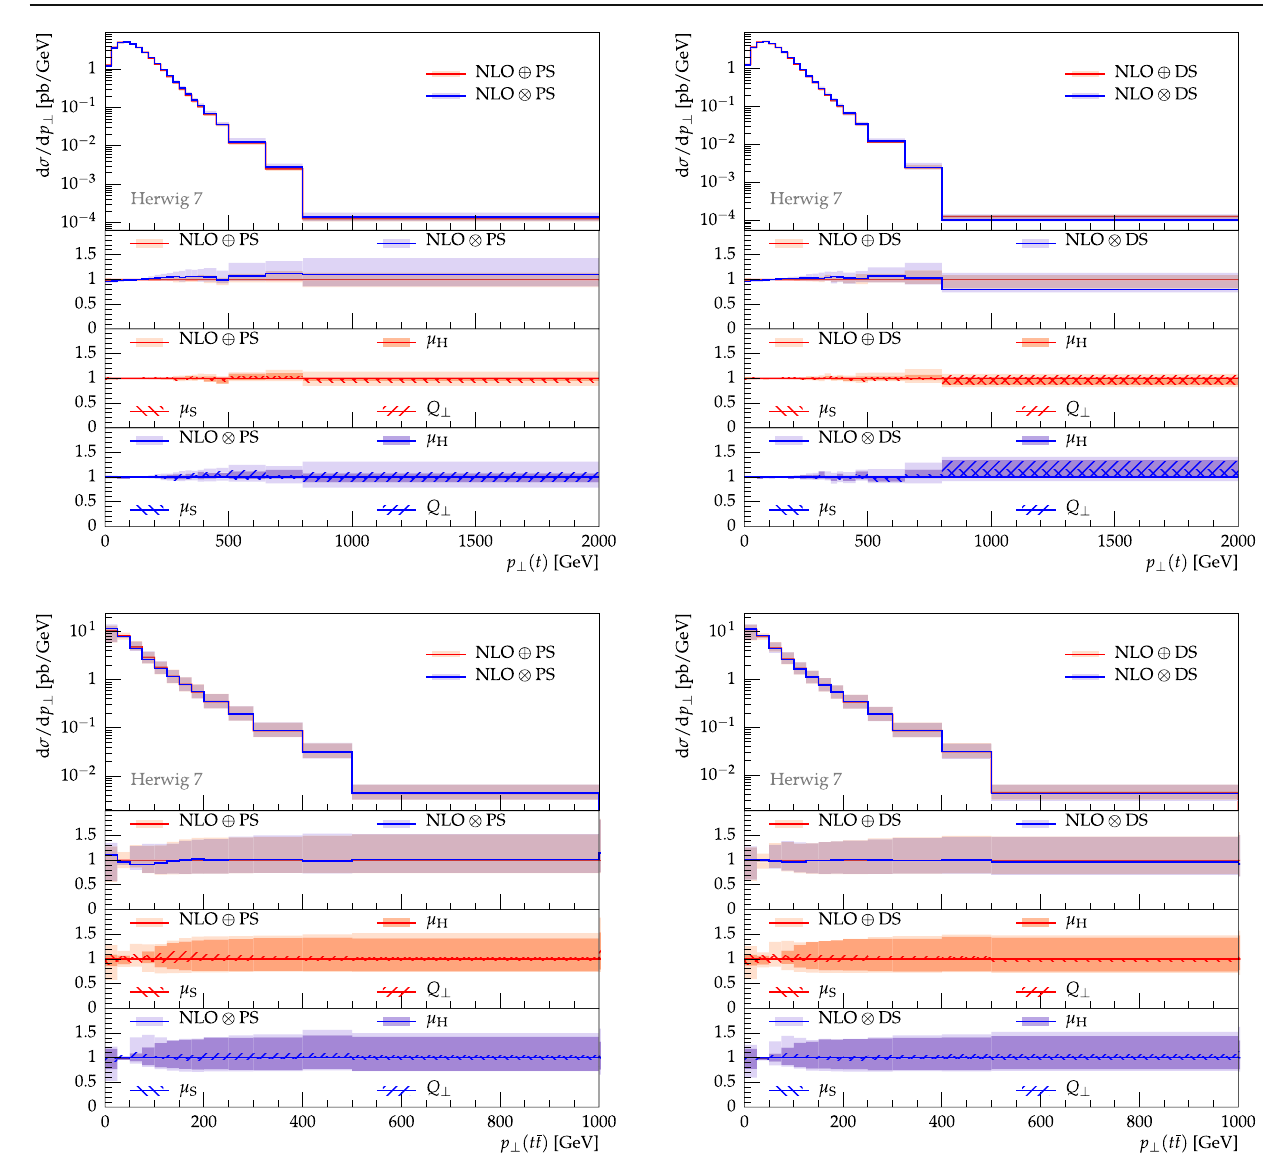
eachplotallowstodirectlycomparetheoverallvariationsinbothmatch- ing variants, in a ratio to the central MC@NLO-type prediction, while the lower two ratio plots in each plot show a breakdown of the varia- tions for both matching variants regarding the hard process scale( μ H ), the shower scale ( μ S ) as well as the hard veto scale ( Q ⊥